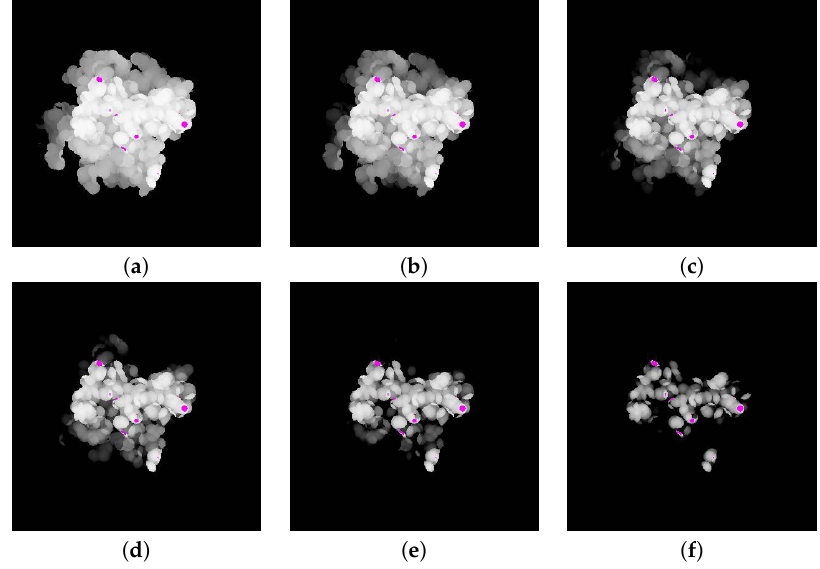
Figure 7. Difference images of depth values: ( a ) original difference image and ( b – f ) quantized difference images using thresholds of 30, 20, 15, 10, and five,